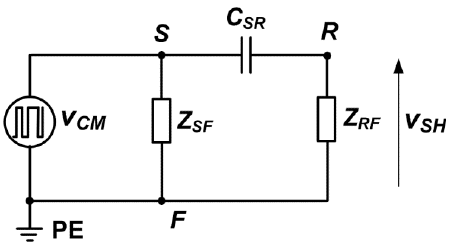
Figure 5. A model of an induction machine common-mode